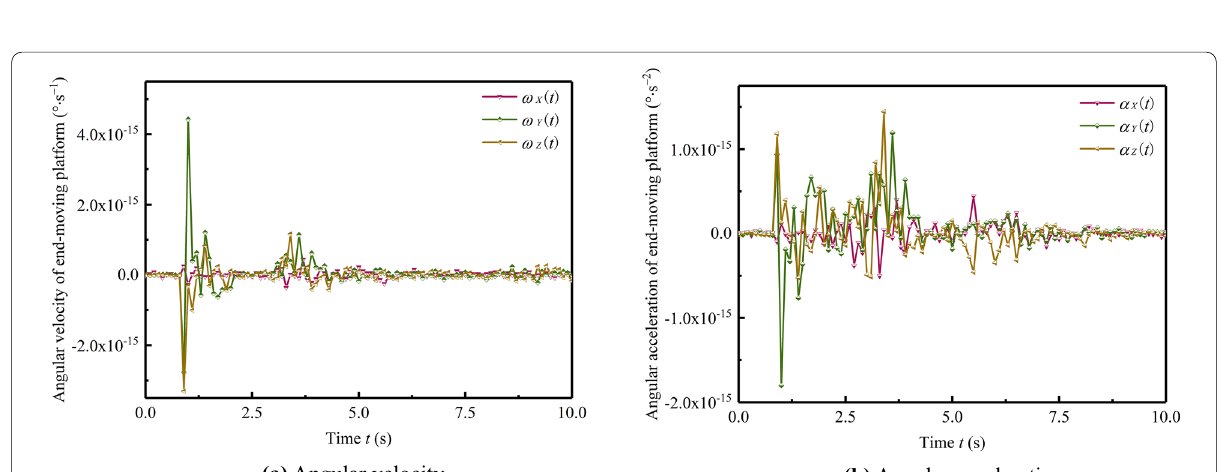
Figure 13 Errors between the two methods of the inverse kinematics analysis